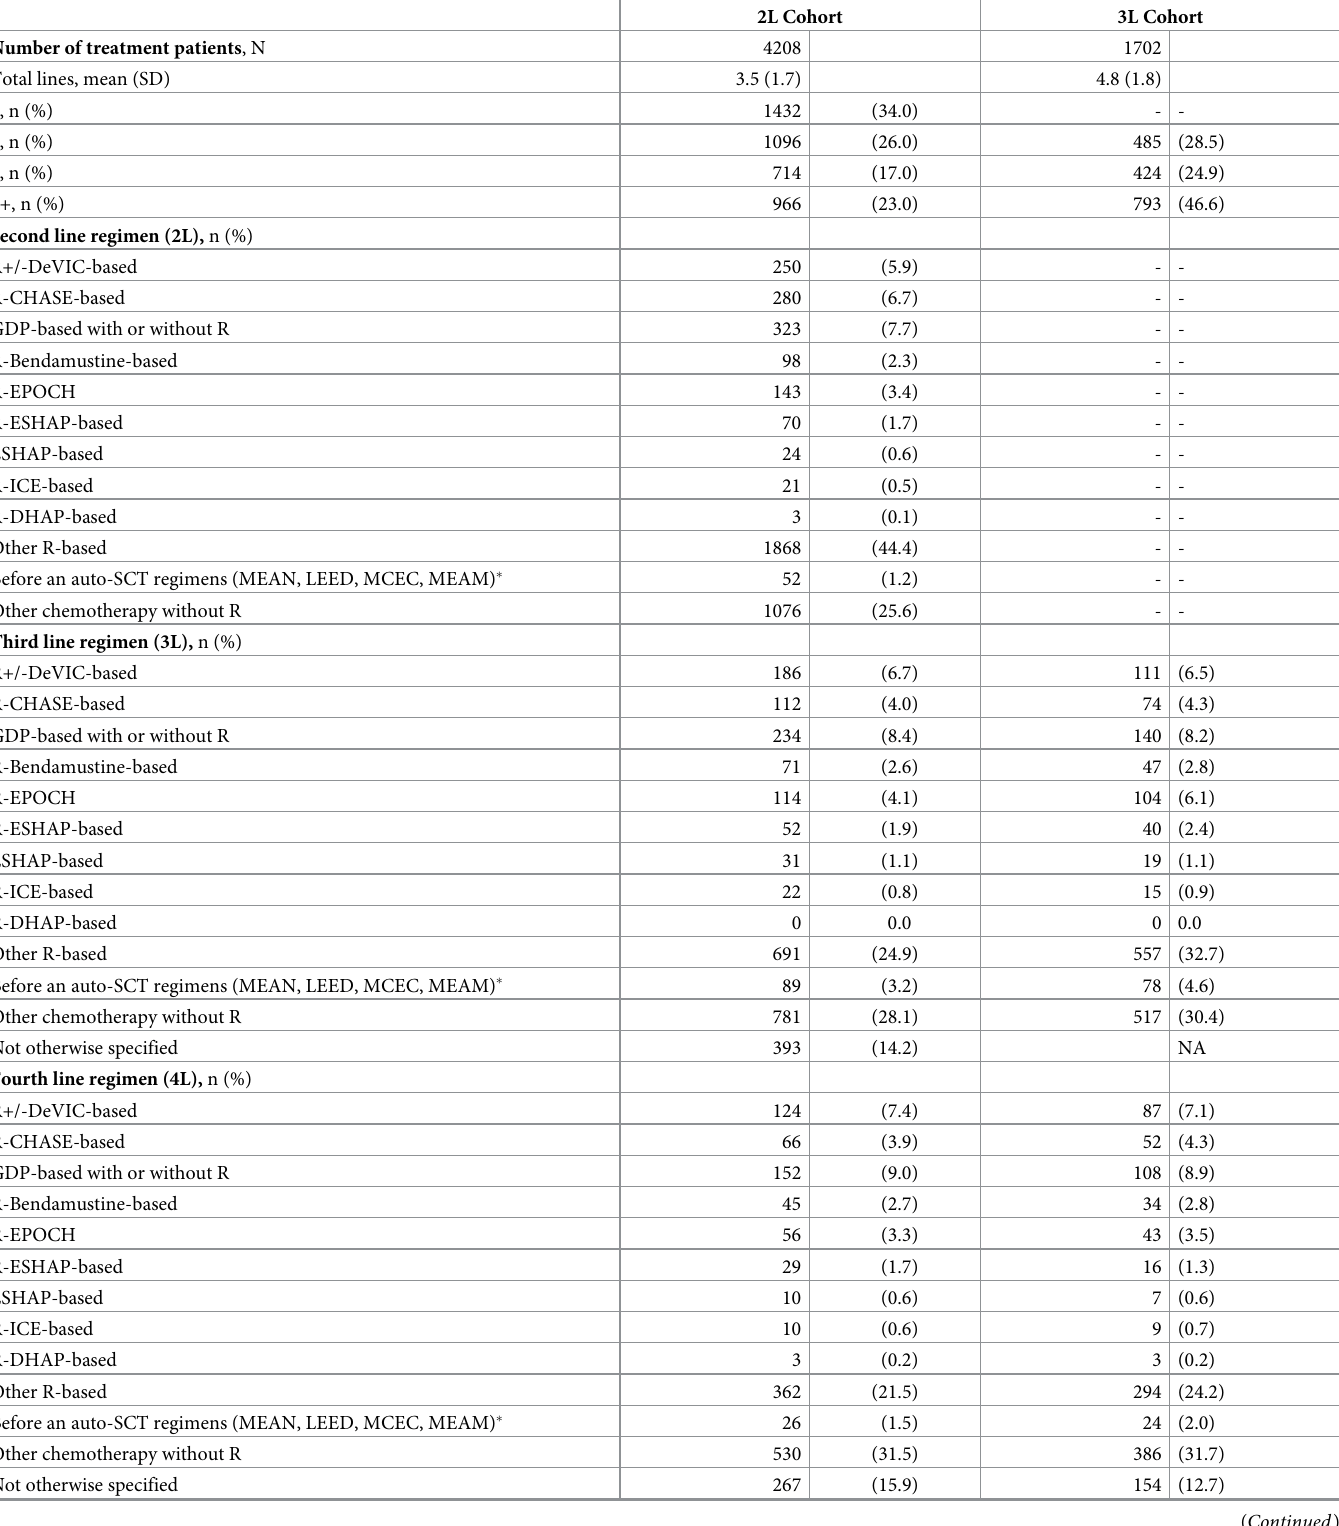
Table 2. Treatment patterns for rrDLBLC